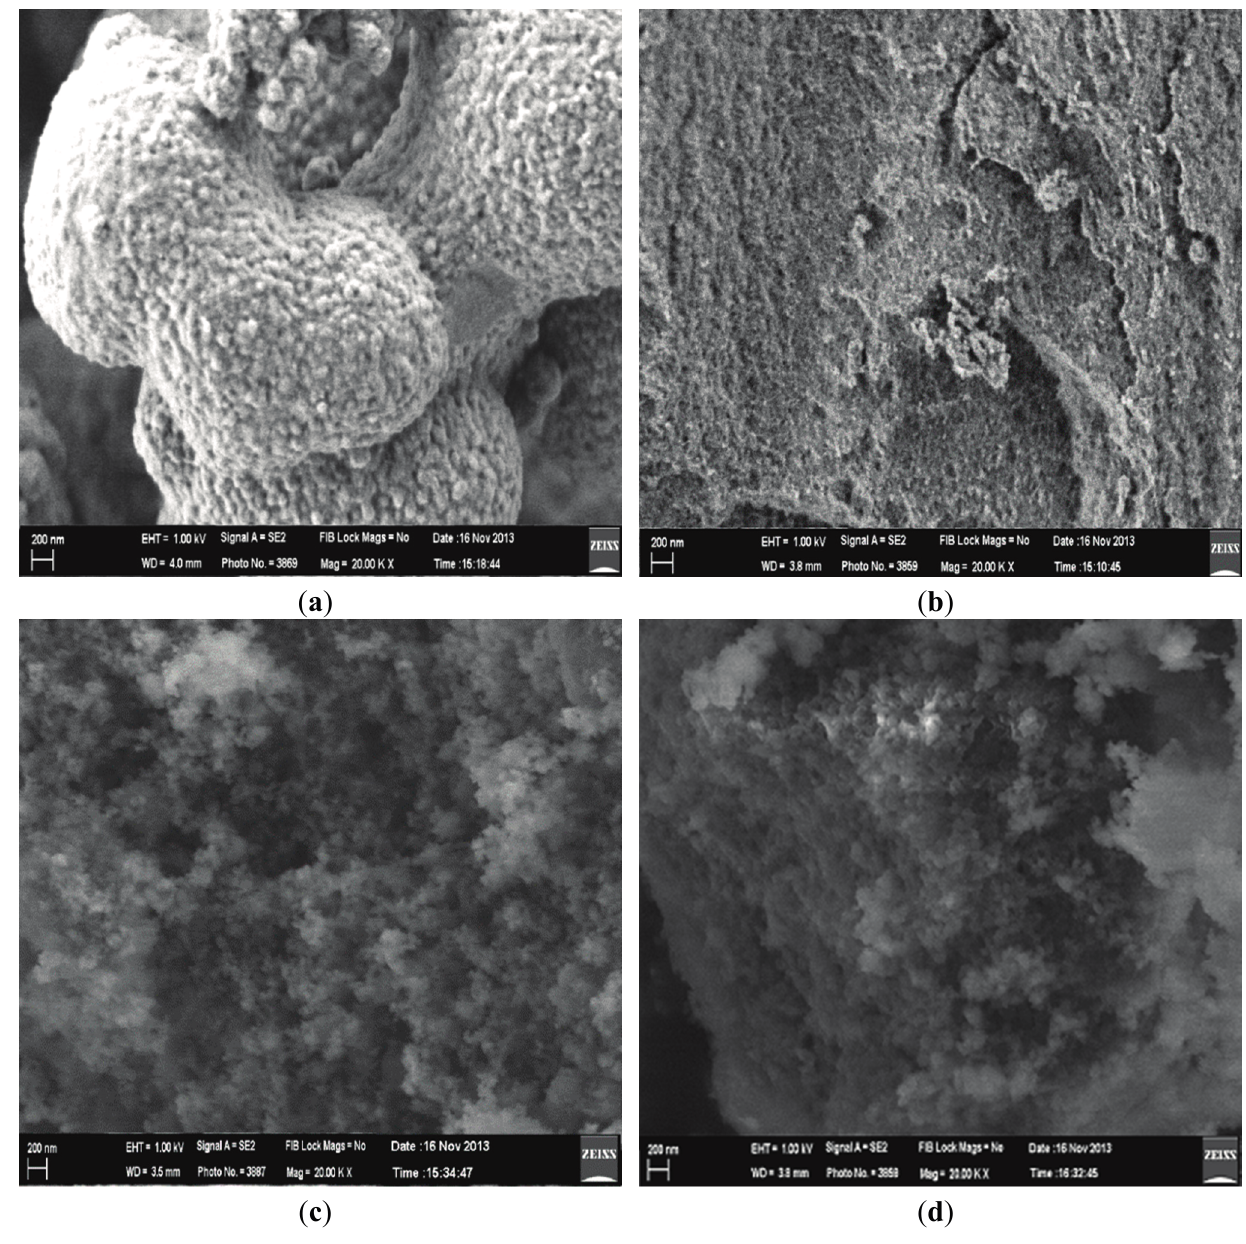
Figure 7. FESEM micrographs of ( a ) MIP1; ( b ) NIP1; ( c ) MIP2; ( d )